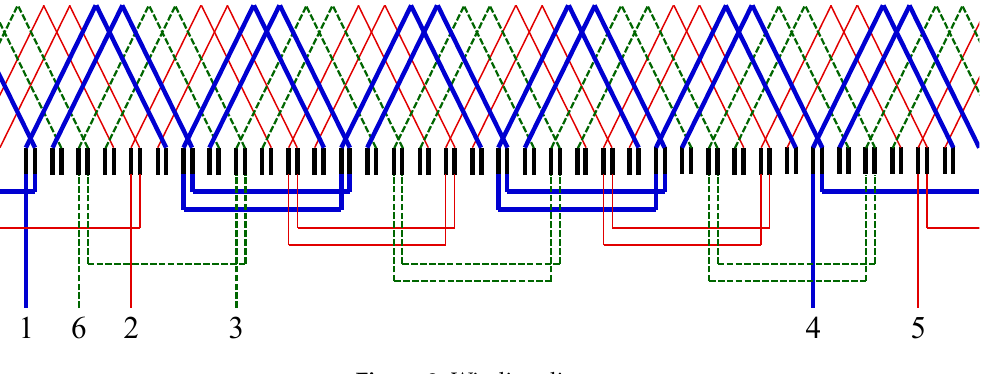
Figure 3. Winding diagram. Figure 3. Winding